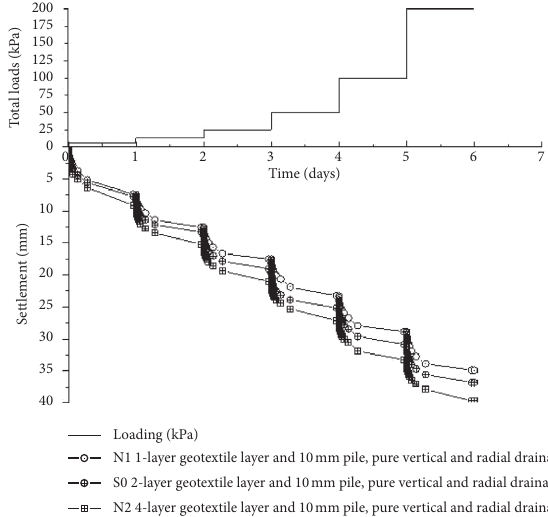
Figure 10: Relationships between consolidation settlement and time under each step loading for tests of Group C (N1, S0, N2).